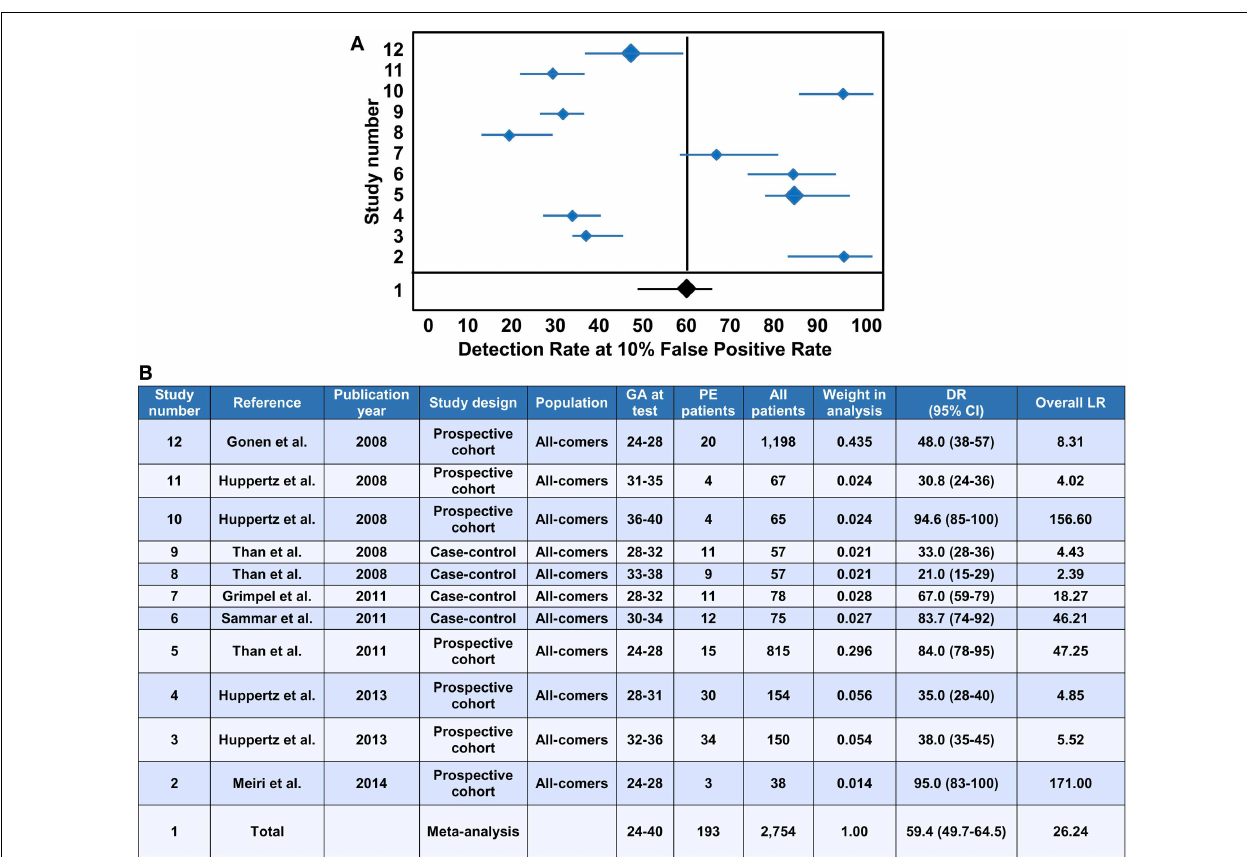
FIGURE 10 | Meta-analysis of PP13 in predicting preeclampsia in the third trimester . (A) A Forest plot analysis was performed including 11 studies based on unaffected and all preeclampsia cases.The detection rate (DR) at 10% False Positive Rate (FPR) of all cases of preeclampsia is shown in case-control and prospective cohort studies using all-comers.The DR was extracted from Receiver Operation Characteristics (ROC) curves based on the adjusted multiple of the medians (MoMs) of PP13.The final analysis took into consideration the total study size and the size of the preeclampsia group. Number 1 on the study list reflects the results of the meta-analysis depicted with a dark filled diamond compared to individual studies depicted with blue